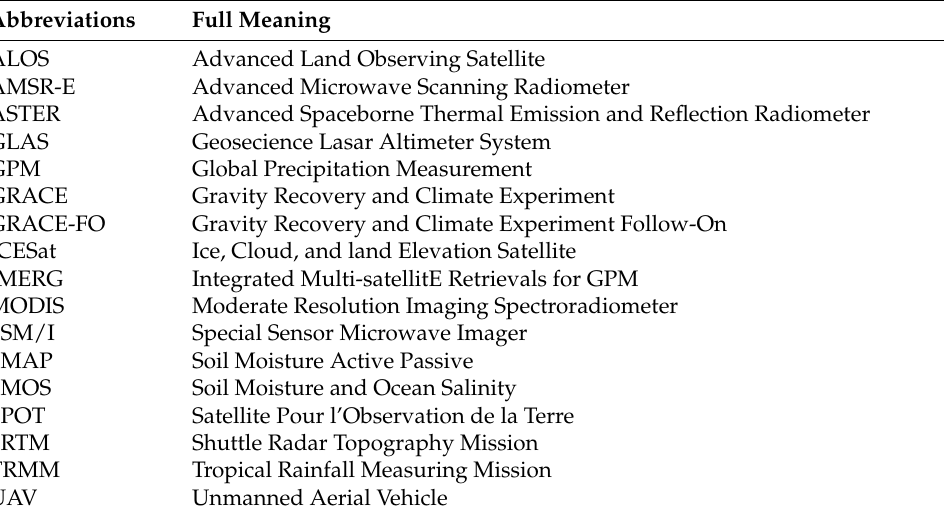
Table A7. List of